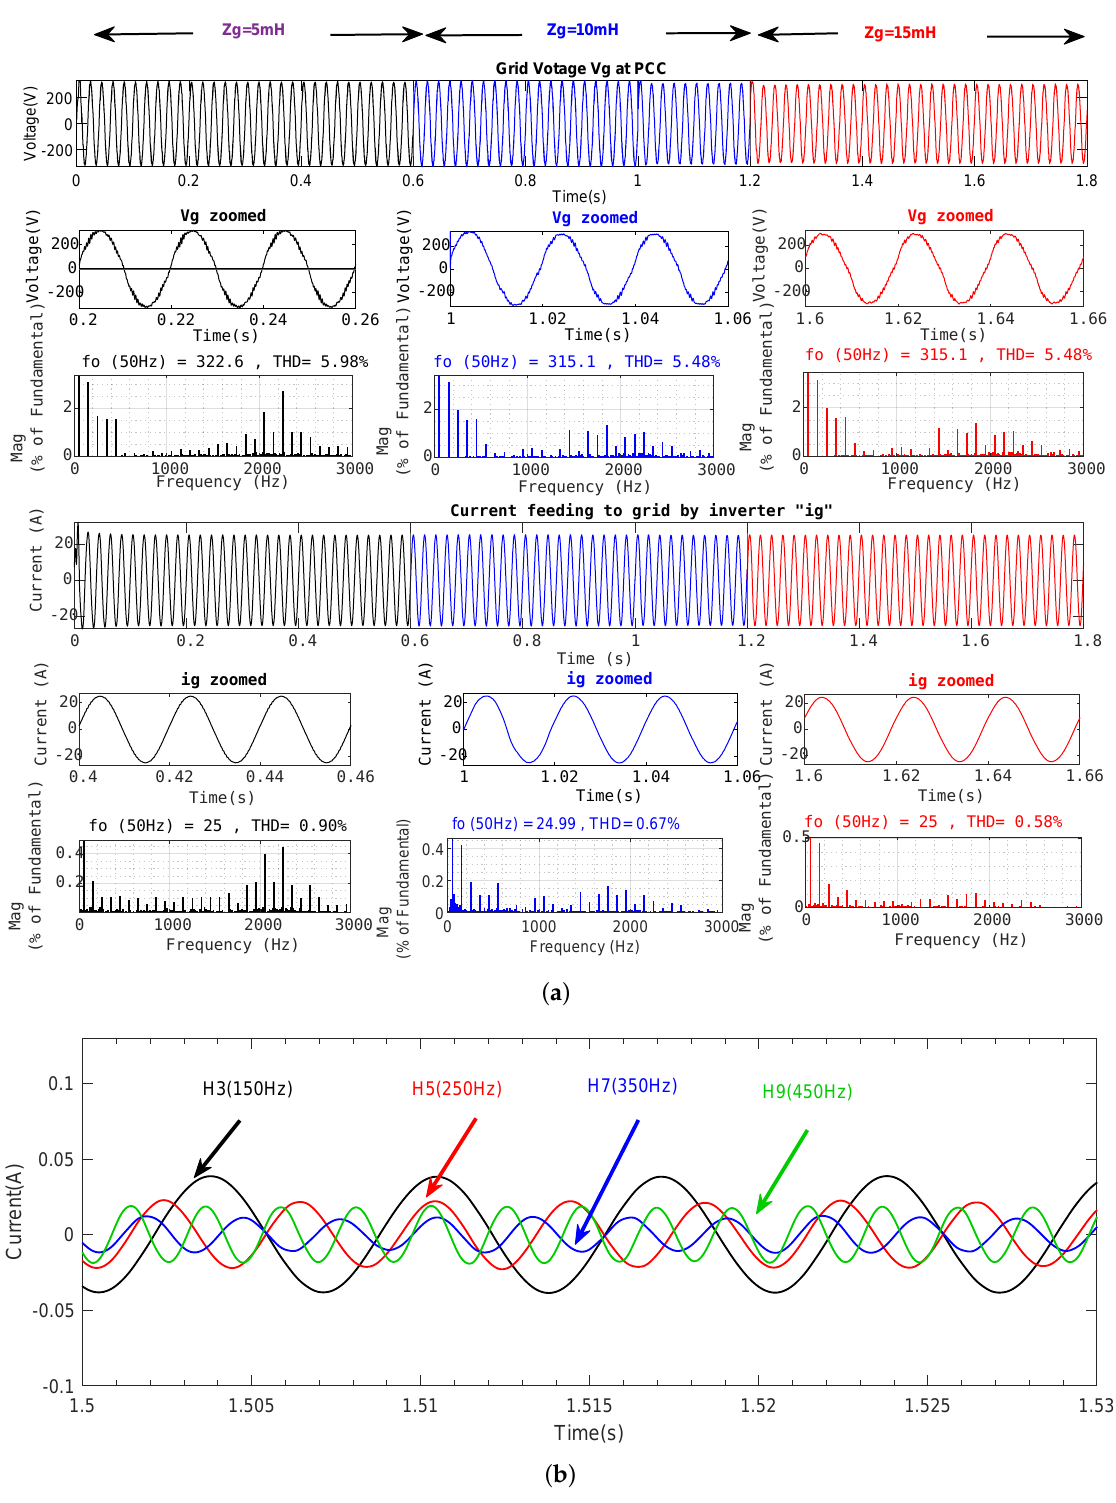
Figure 16. Results of Grid Tied Inverter with proposed harmonic compensator. ( a ) PCC voltage V g and grid current i g along with their respective FFT analysis. ( b ) First four odd harmonics in current i g when grid impedance Z g ( s ) is 15